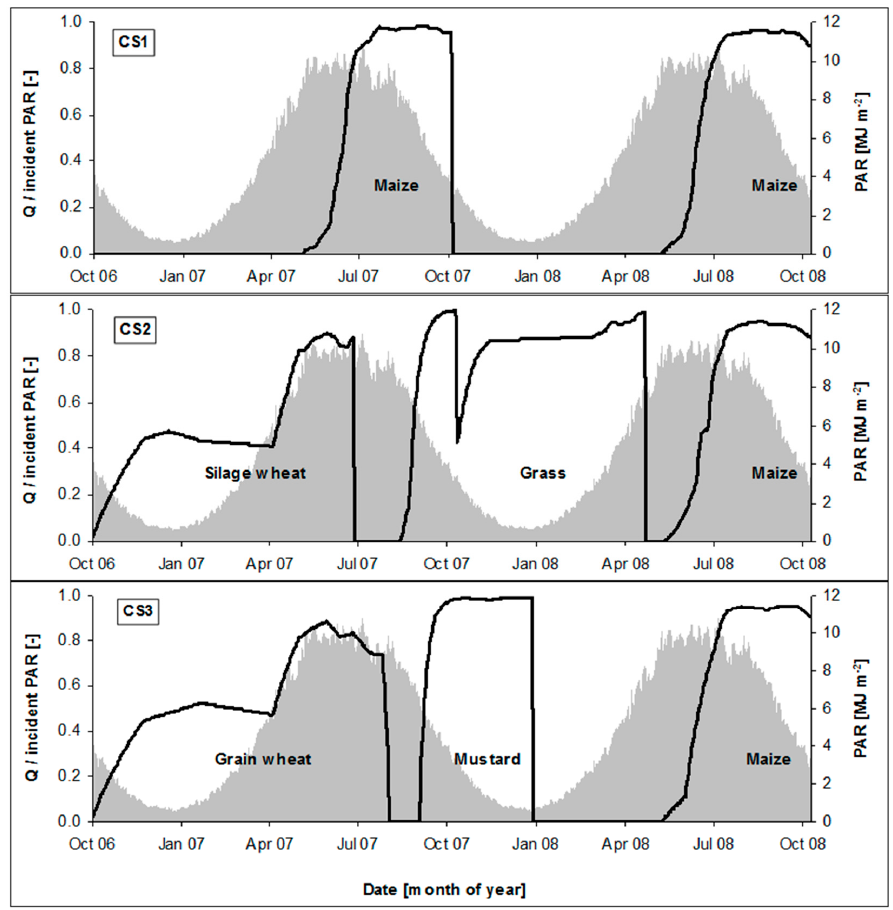
Figure 3. Simulated time courses of the ratio between absorbed and incident PAR (Q/incident PAR) for the three cropping systems cultivated in Hohenschulen (HS) at the N3 treatment (black lines) and a 35-years averaged time course of PAR measured at HS (gray). Table 5. Photosynthetic active radiation (PAR) interception (MJ m − 2 a − 1 ) and light use efficiency (g MJ − 1 ) of cropping systems in Hohenschulen (HS) and Karkendamm (KD), separated between